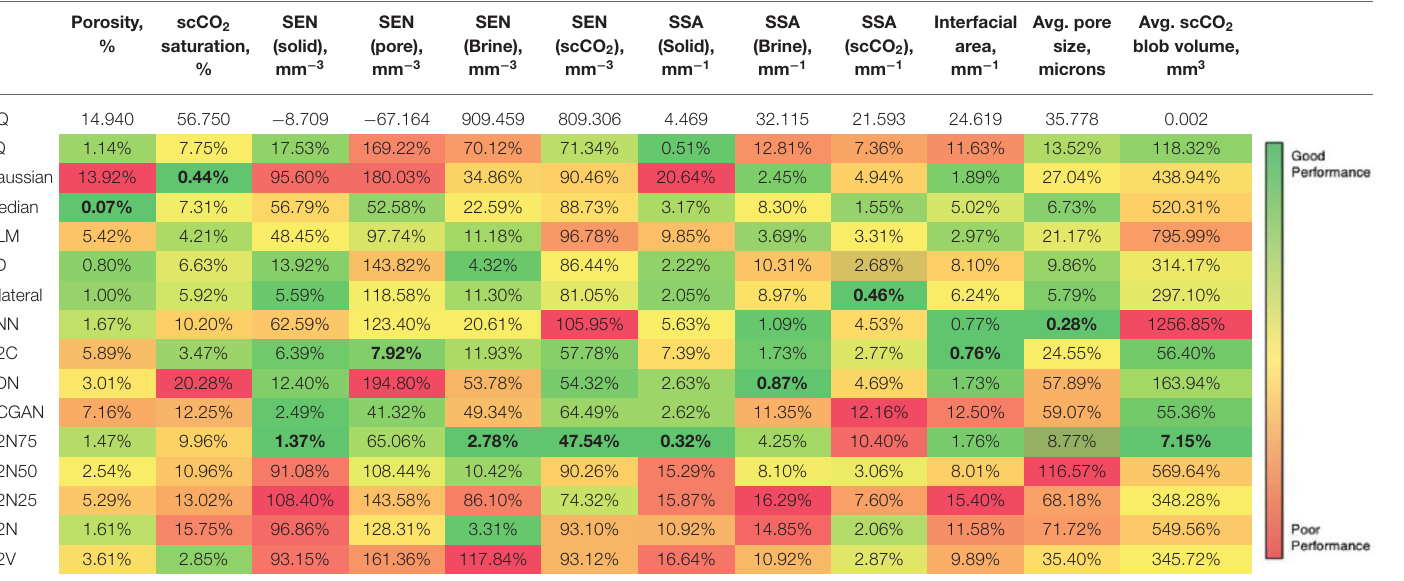
TABLE 7 | Physics-based comparison of denoising algorithms using bulk and pore-scale petrophysical properties.